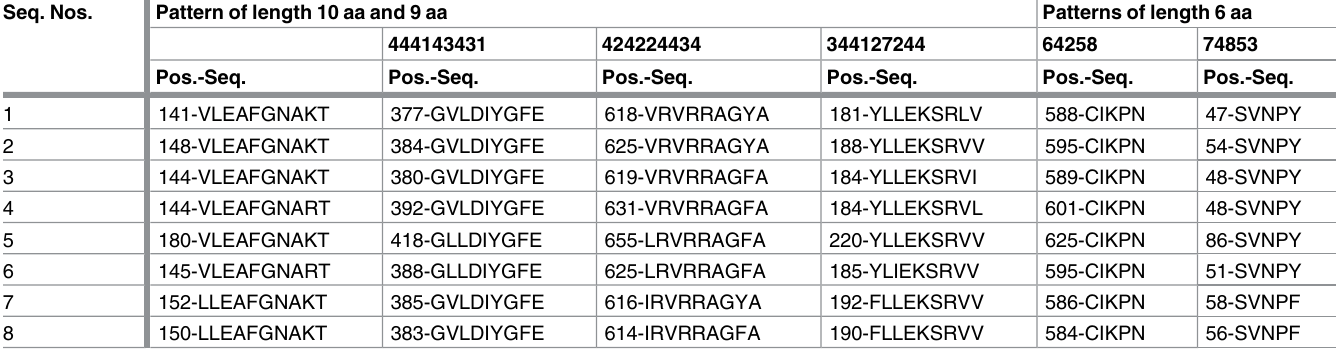
Table 16. Conserved chemical patterns in MYOI family members, their position and original amino acids sequences. Seq.